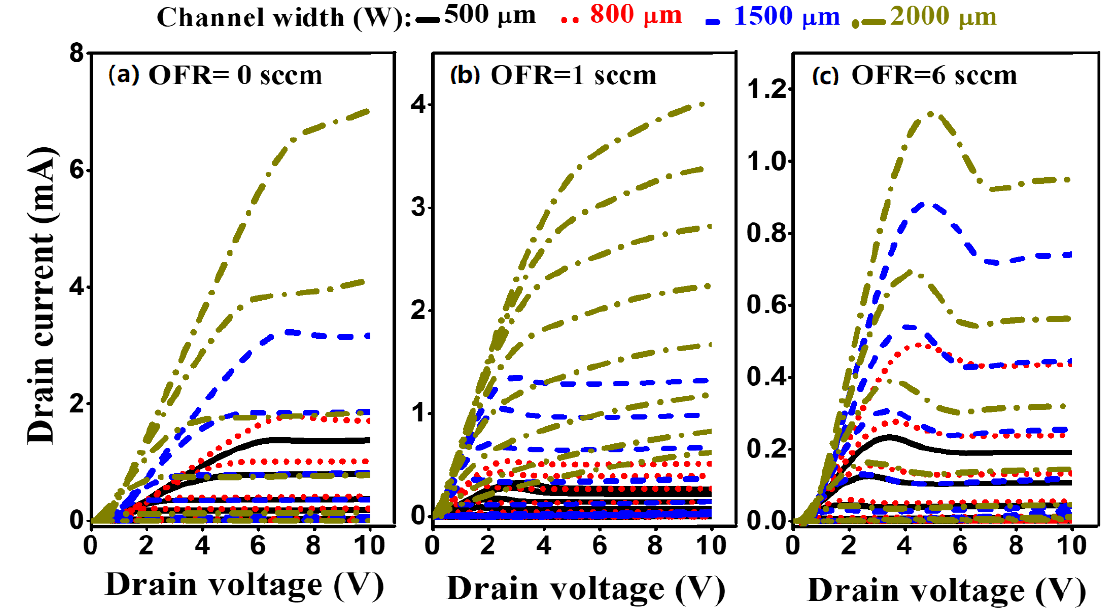
Figure 10. The output characteristics of a -IGZO TFT at an oxygen flow rate of ( a ) 0 sccm, ( b ) 1 sccm and ( c ) 6 sccm. The gate voltage varied − 1 V to 3 V with an increased step voltage of 0.5 V. (Solid, dot, dash and dot–dash lines represented for channel width 500 µ m, 800 µ m, 1500 µ m and 2000 µ m,